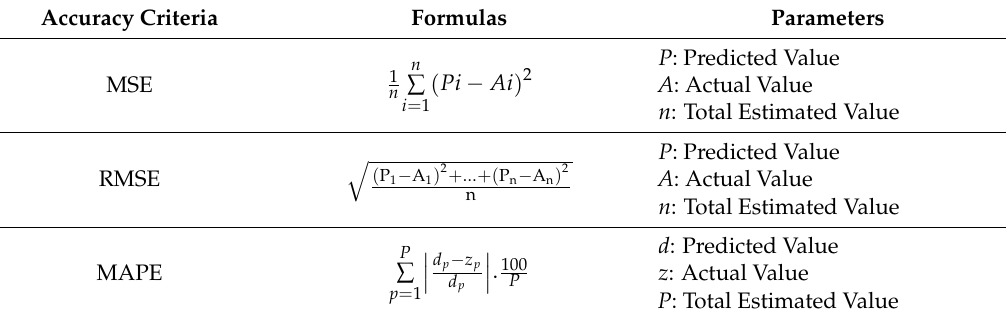
Table 2. The accuracy criteria and formulas